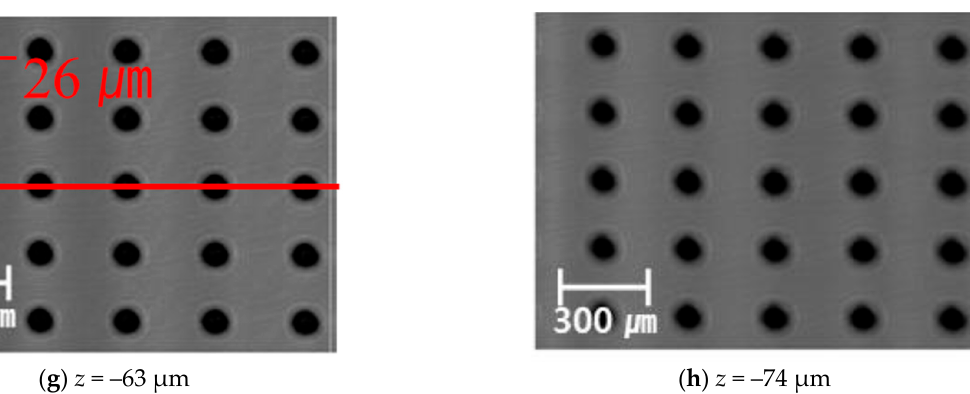
Figure 10. C-Scan image by the depth of TSV internal defect using acoustic microscope system imaging technique.